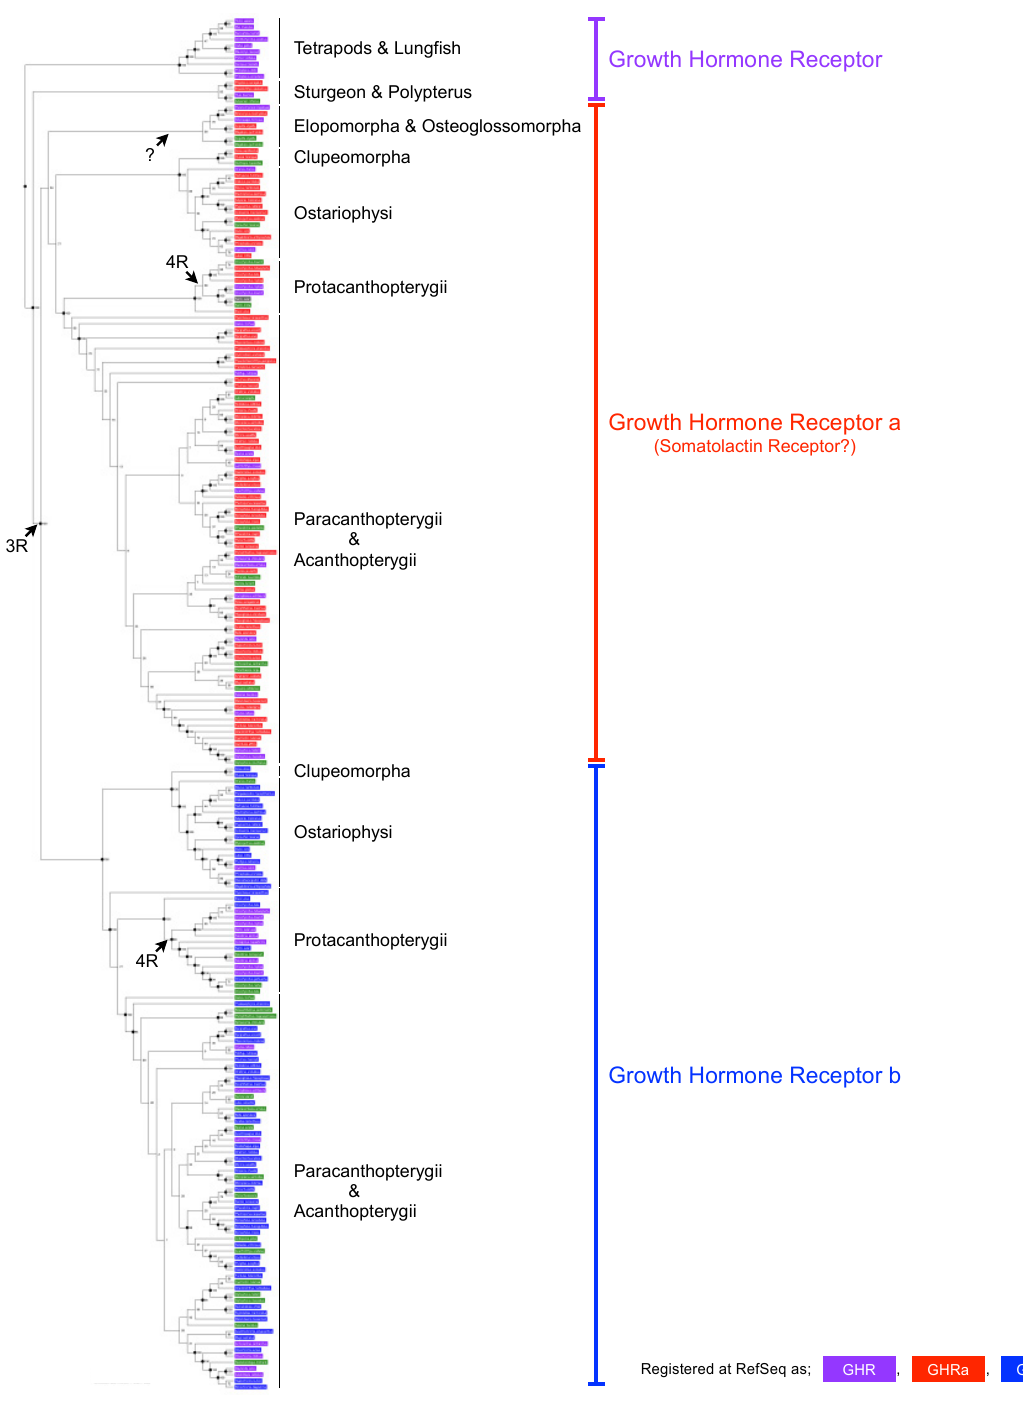
Figure 2. Cladogram of the GHR sequences registered at the RefSeq protein database. A total of 222 sequences (136 species) were used for phylogenetic tree reconstruction using the maximum-likelihood method. Sequences classified in the database as GHR, GHRa, GHRb, GHR-like, or other are colored in purple, red, blue, green, or gray, respectively. Bootstrap values are shown at each node, and nodes with a bootstrap value of 90% or more are labeled by black dots. Three groups (GHR of tetrapods, lungfish, sturgeon, and polypterus [purple]; GHRa [red] of teleosts; and GHRb [blue] of teleosts) are supported by bootstrap values of 100%. This figure revealed many problems in the nomenclature of GHRs.